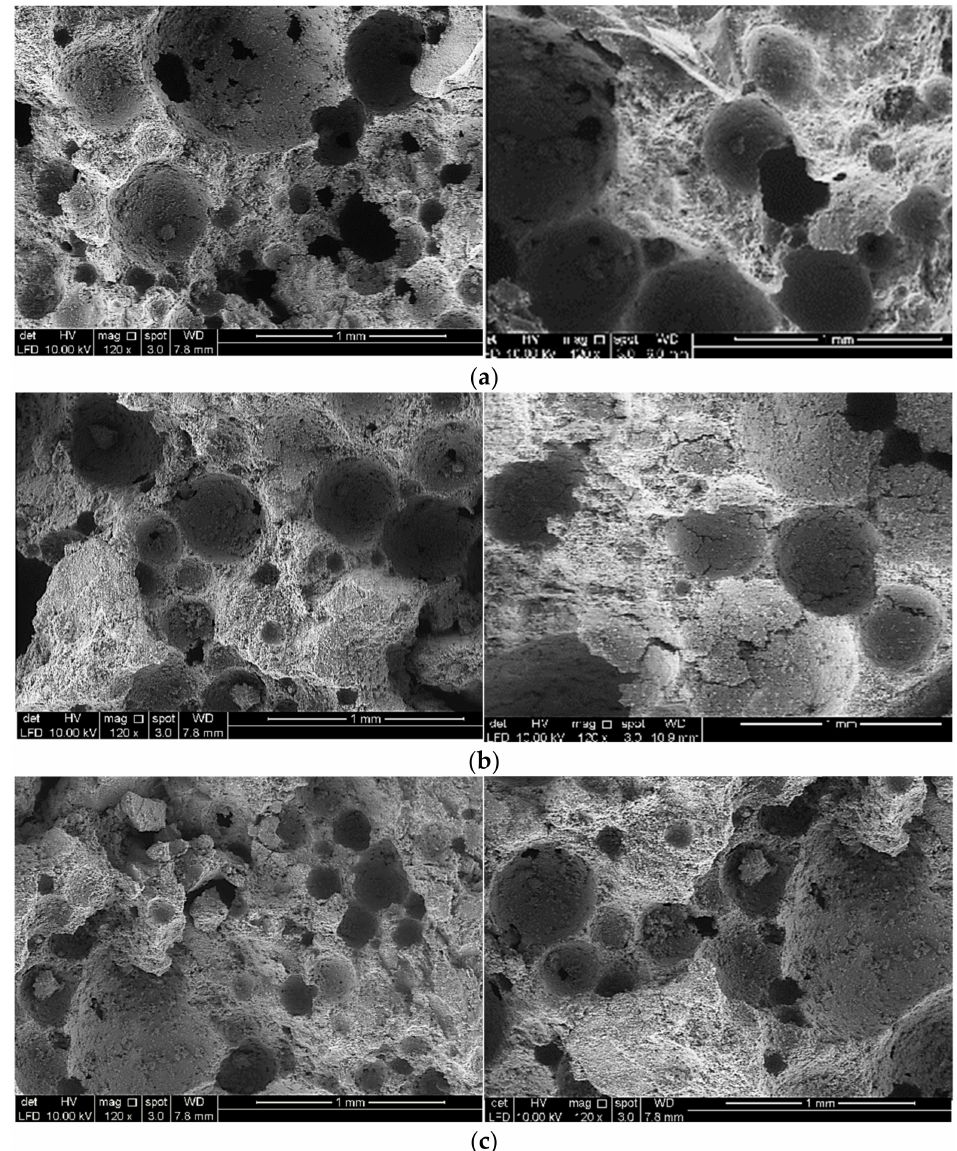
Figure 7. Comparison of SEM micrographs of varying densities at ambient temperature and after exposure to 600 ◦ C. ( a ) 500 kg/m 3 density at 20 ◦ C (left) and at 600 ◦ C (right); ( b ) 1000 kg/m 3 density at 20 ◦ C (left) and at 600 ◦ C (right); ( c ) 1500 kg/m 3 density at 20 ◦ C (left) and at 600 ◦ C